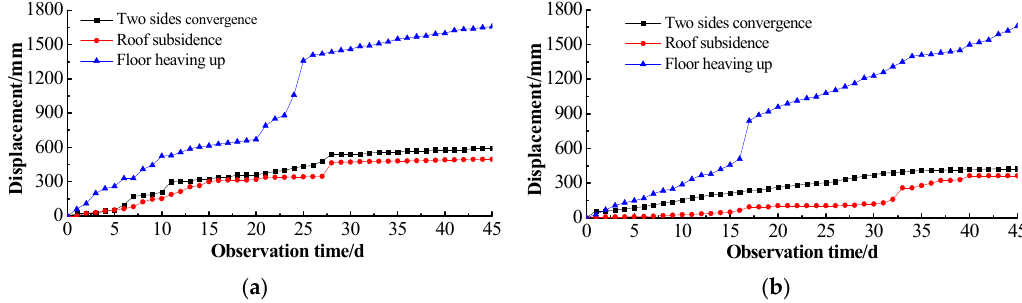
Figure 1. Roadway deformation in stations 3 and 4 [28]. ( a ) Deformations of station 3; ( b ) Deformations of station 4.